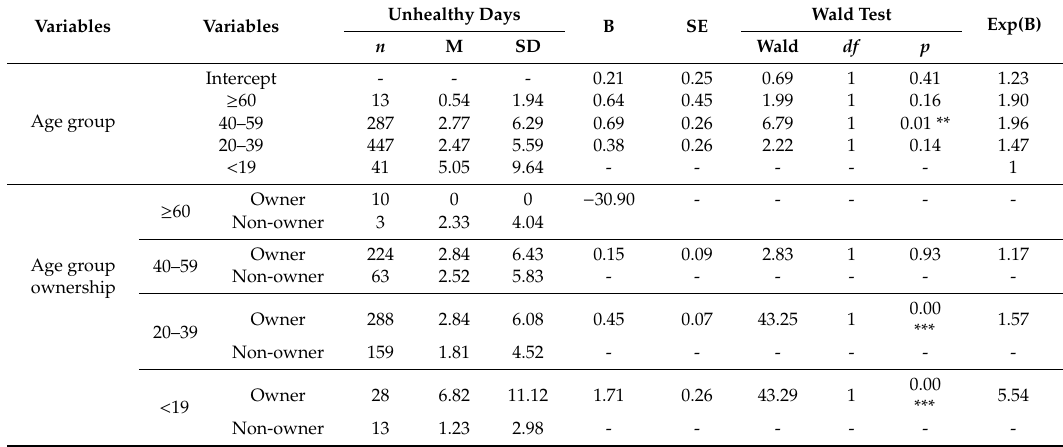
Table 3. Poisson regression of the impact of age and ownership on the occurrence of unhealthy days. Unhealthy Days Variables Variables